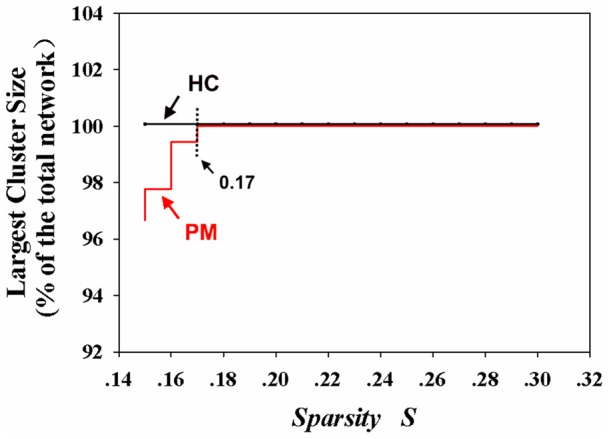
Largest cluster size as a function of sparsity S for the healthy controls' (HC) structural networks (black line) and patients' with migraine (PM) structural networks (red line).S = 0.17 is the lowest sparsity value that could guarantee each network was fully connected with all of the nodes.